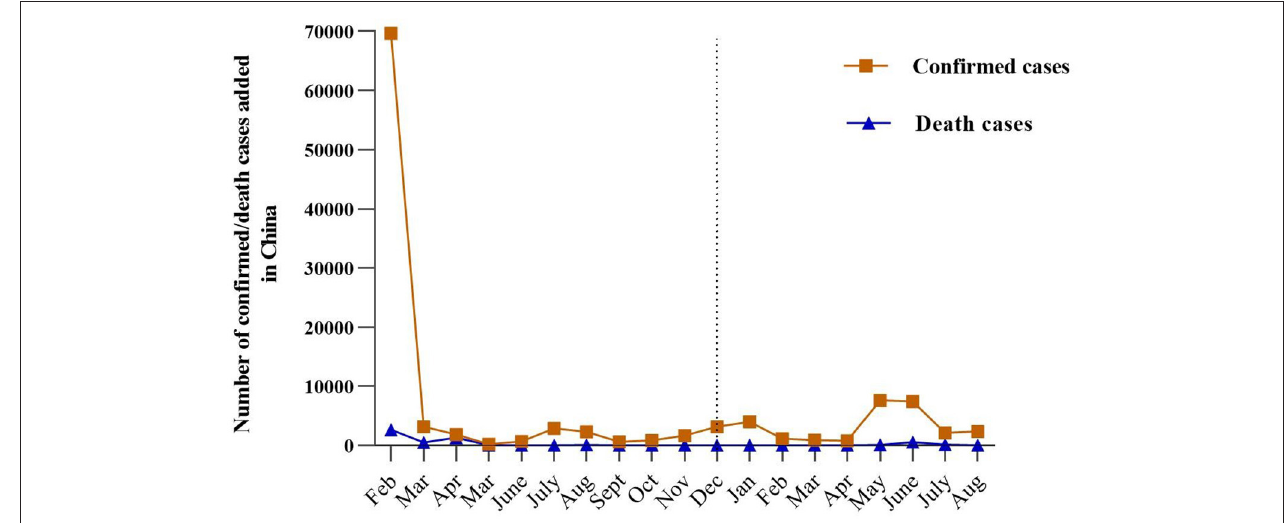
FIGURE 1 | Trajectory of the COVID-19 pandemic in China (including Hong Kong, Macao, and Taiwan) with the number of confirmed and deaths cases added each month from February 2020 to April 2021. The left side of the dotted line is 2020, and the right side is 2021.